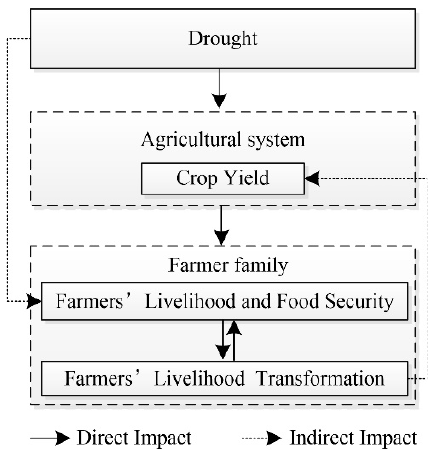
Figure 1. The analytical framework of the integrated impact of drought in rural